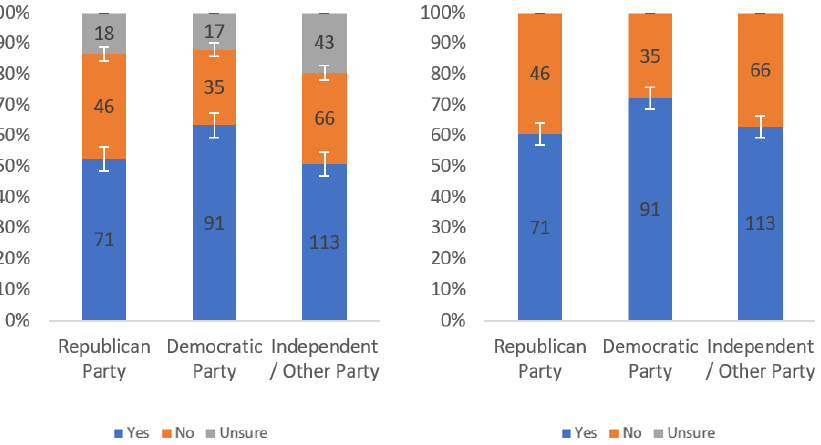
Figure A38. Responses regarding respondents’ willingness to review by party affiliation including ( left ) and excluding ( right ) unsure responses.